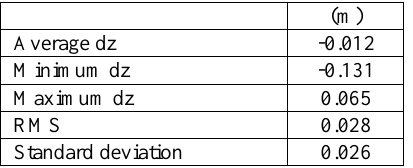
Table 3. Comparison results of VRS-GNSS check point to the MLS point